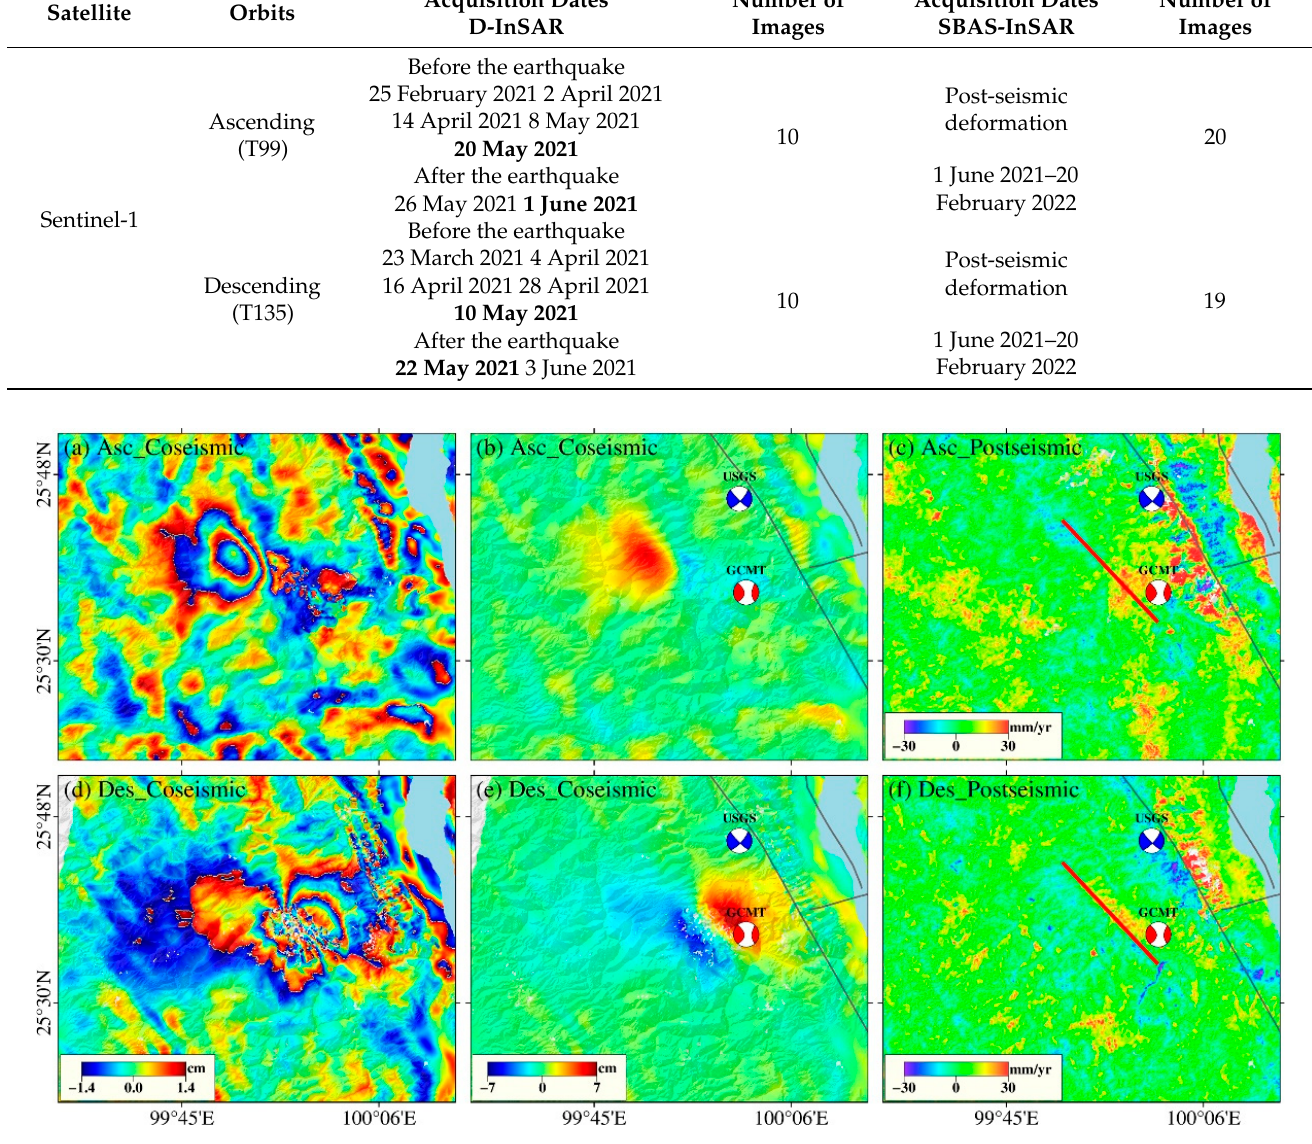
Figure 2. Coseismic and postseismic deformation fields of the 2021 Yangbi earthquake. ( a ) and ( d ) are the ascending and descending InSAR-derived interferograms, respectively. ( b ) and ( e ) are the corresponding unwrapped LOS deformations. ( c ) and ( f ) are the same as ( a ) and ( d ) but for the postseismic deformation rate. Red and blue beach balls show the focal mechanism solutions supplied by the USGS and GCMT catalogs, respectively. Red lines in ( c ) and ( f ) are the seismogenic faults used in source modeling. Thin grey lines indicate the regional active faults.